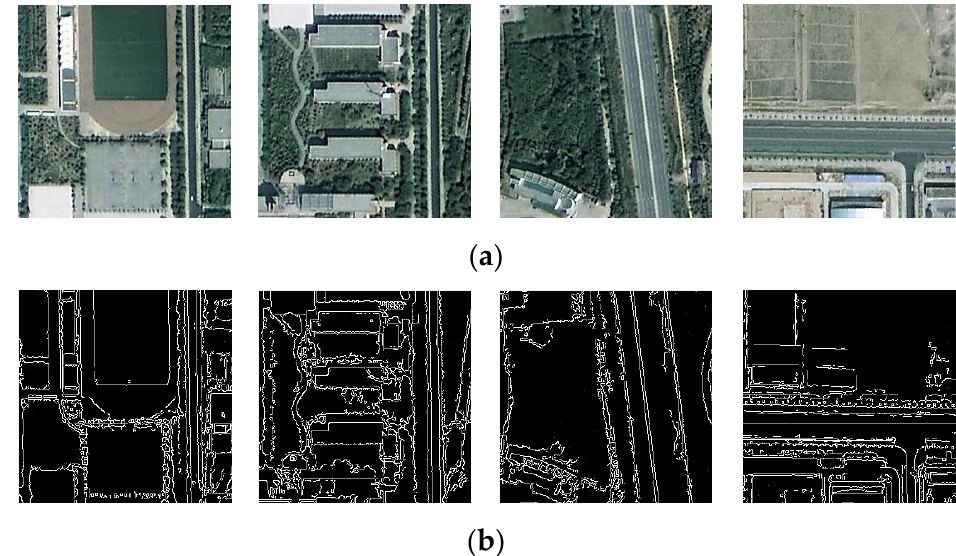
Figure 8. Example of robust edge feature samples made based on the method of [3]: ( a ) Original HRRS images, ( b ) label images for MUM-Net.